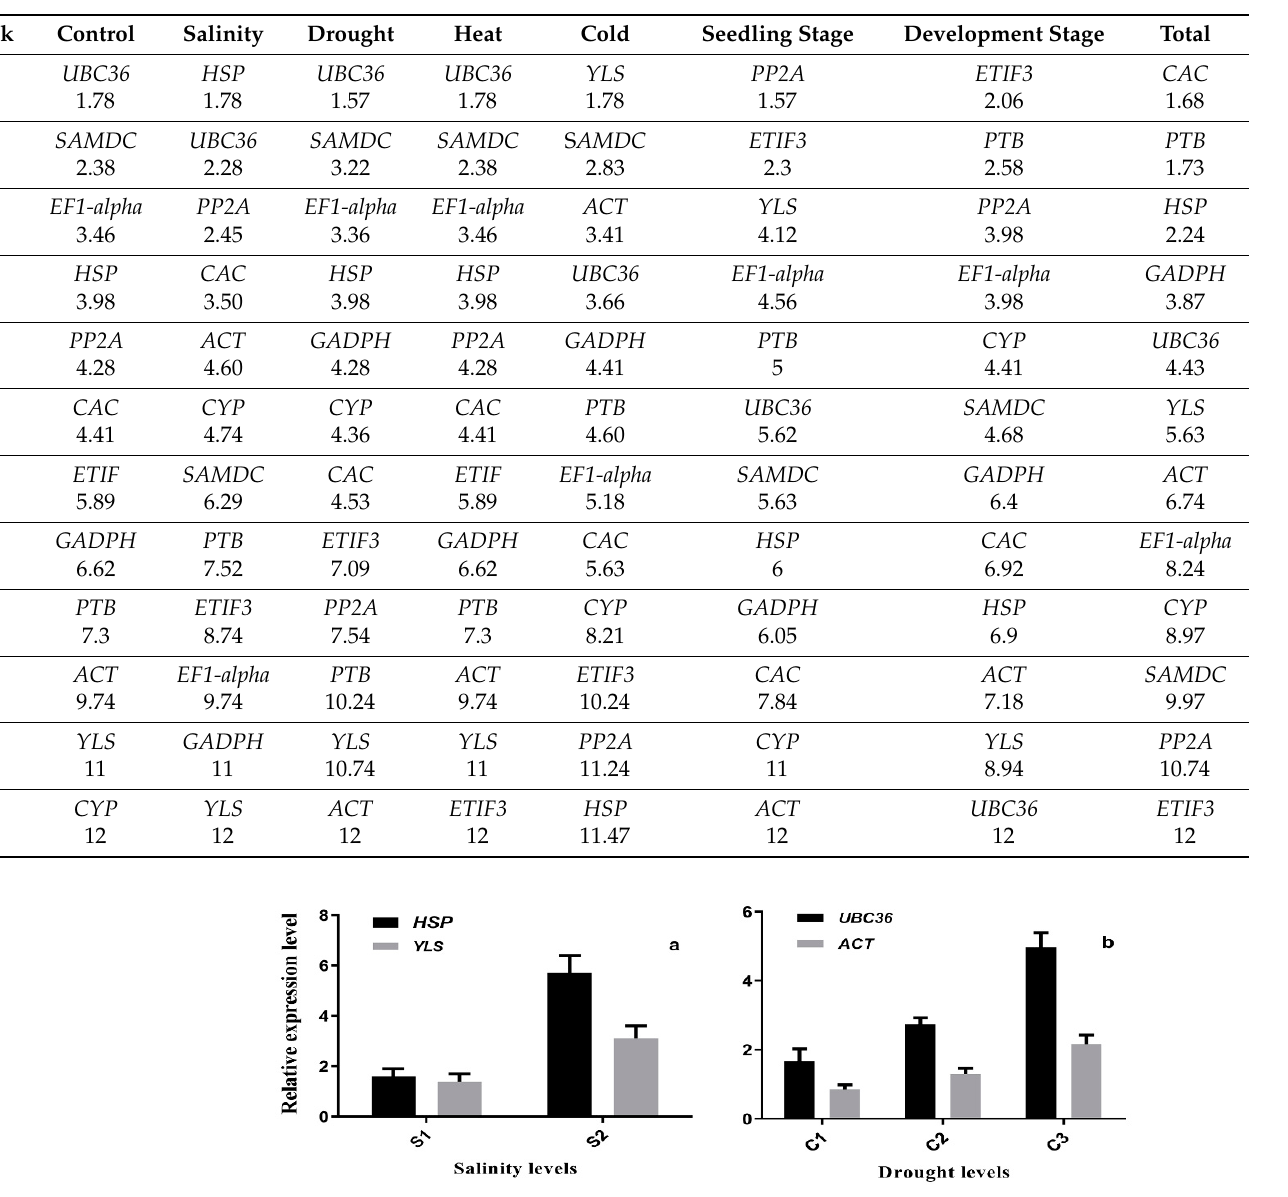
Figure 5. Relative expression level of target genes ( NHX1 and DREB ) under salinity and drought stress, whereas salinity (S1 = 50 mM NaCl and S2 = 150 mM NaCl) ( a ) and drought (C1 = control, C2 = 75 g L − 1 PEG-6000 and C3 = 100 g L − 1 PEG-6000) ( b ) conditions.